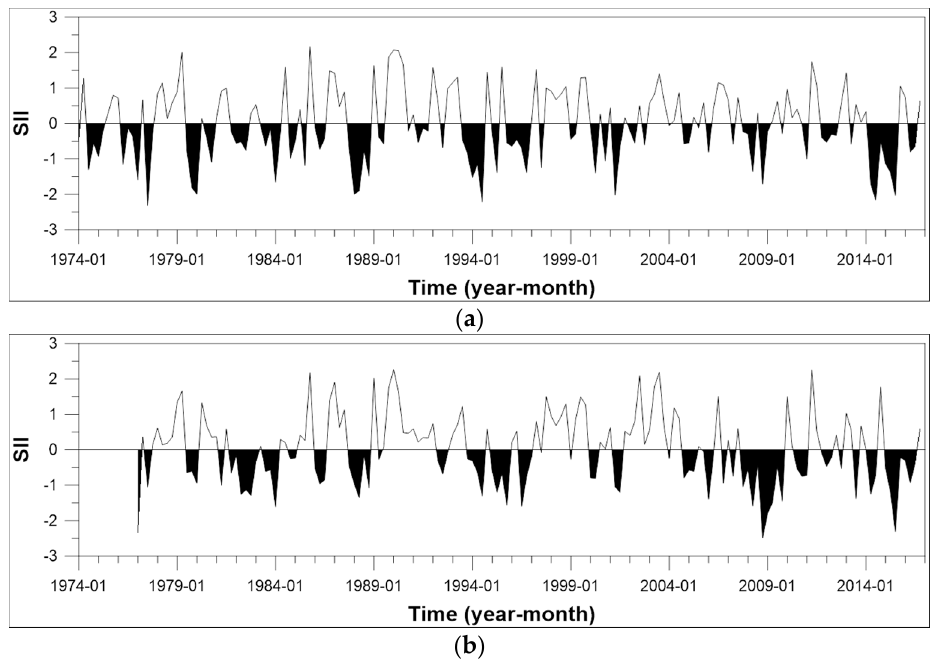
Figure 11. Quarterly SII: ( a ) Soyanggang dam; ( b ) Andong dam.